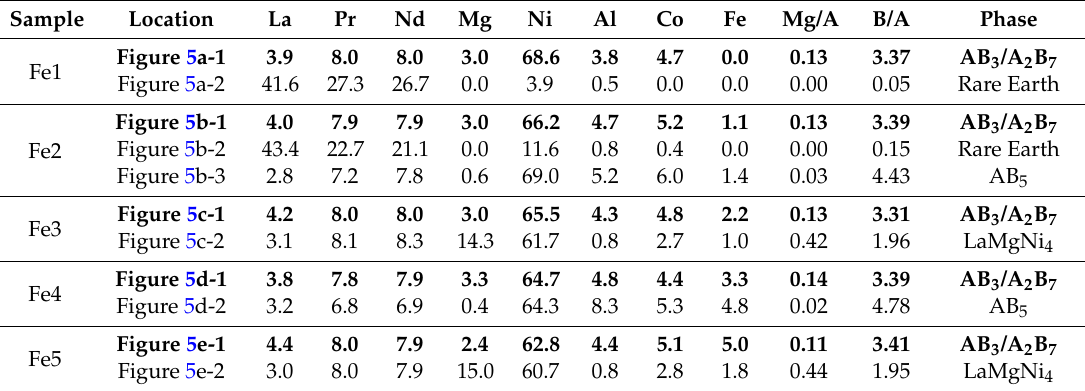
Table 3. Summary of EDS results. All compositions are in at%. The composition of the main phase is in bold .